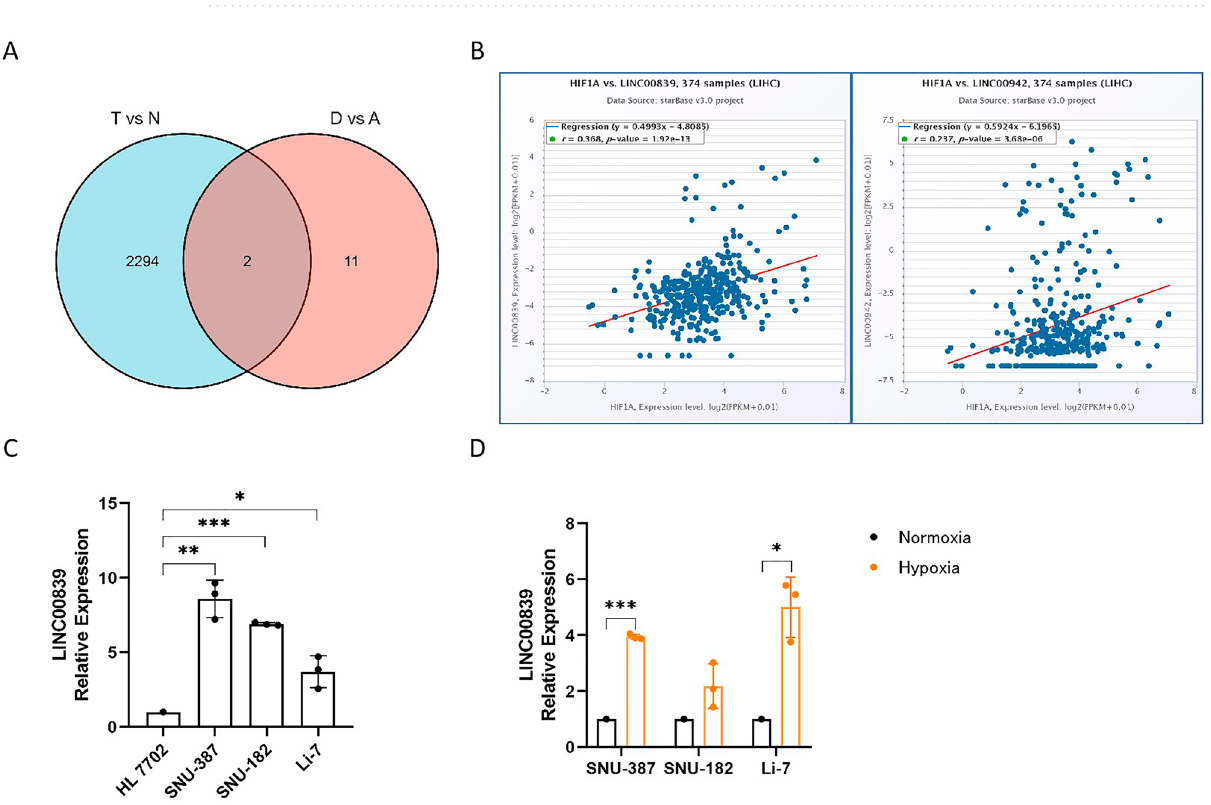
Figure 2. Hypoxia-responsive LINC00839 is selected in liver cancer and validated under hypoxia. ( A ) Venn diagram of differently expressed lncRNAs in two sets. ( B ) The co-expression analysis of LINC00839 and LINC00942 with HIF1A in LIHC. ( C ) The relative expression of LINC00839 in liver cancer cell lines and normal liver cell line. ( D ) The relative expression of LINC00839 in liver cancer cells under normoxia and hypoxia. The experimental data was represented by mean ± SD from at least three independent experiments. * P < 0.05, ** P < 0.01, *** P <